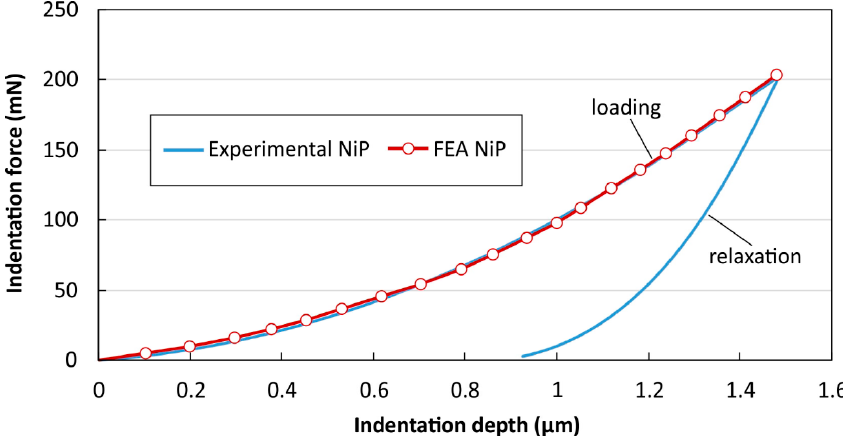
Figure 9. Comparison between FEA-determined and experimental nanoindentation tests.